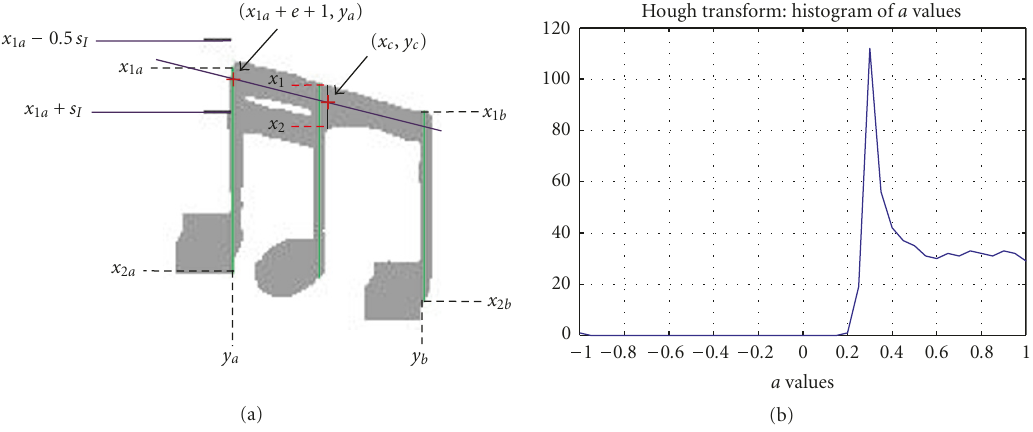
Figure 10: Detection of a beam connecting a stem in y a and a stem in y b . (a) Parameters involved in the region growing process and modified Hough transform. (b) Hough accumulator leading to the beam slope